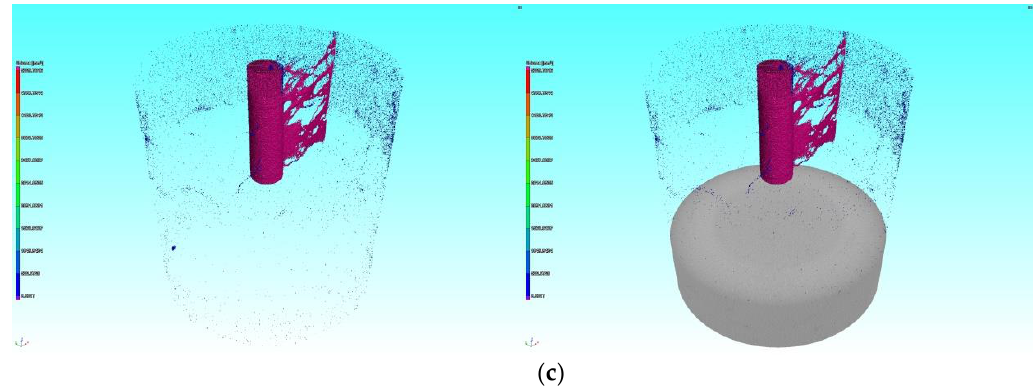
Figure 9. Fracture morphology after hydraulic fracturing of specimen using gelled acid: ( a ) CT scanning along the axis; ( b ) CT scanning perpendicular to the axis; ( c ) fracture spatial morphology.